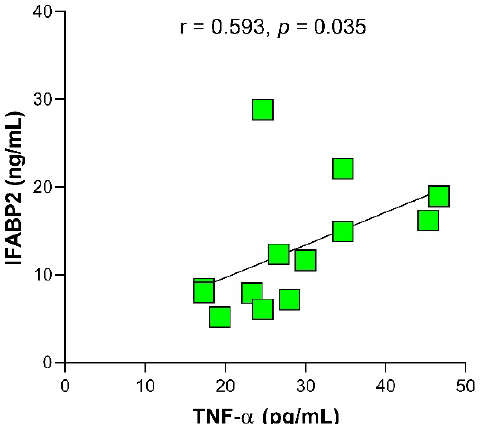
Figure 2. Correlation between seric levels of IFABP2 and TNF- α in RA patients with treatment. Spearman’s correlation. r = rho, correlation coefficient. p -Value < 0.05 was considered statistically significant.